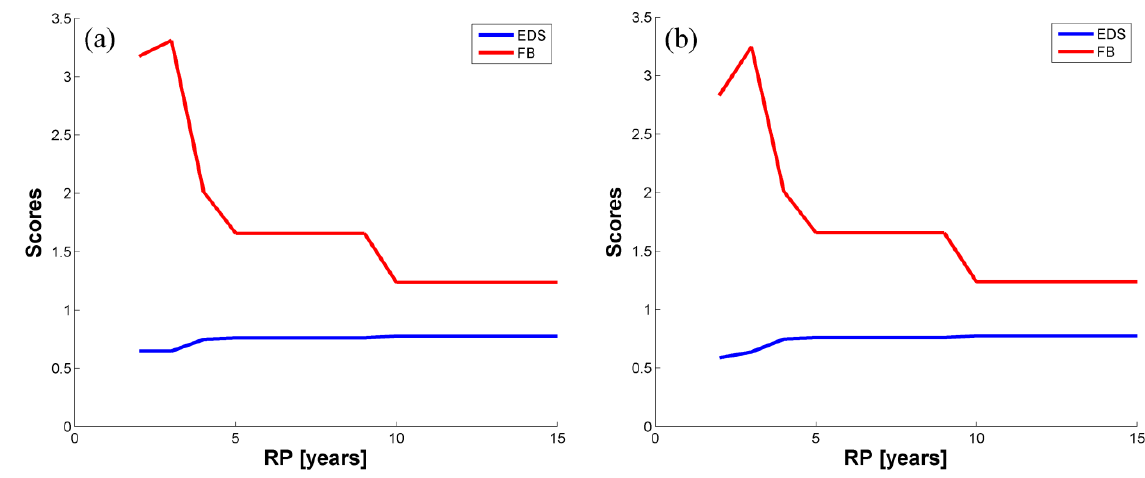
Figure 9. Scores of RPs for ( a ) HM FE and ( b ) HM GDF compared against the LISFLOOD-FP reference.